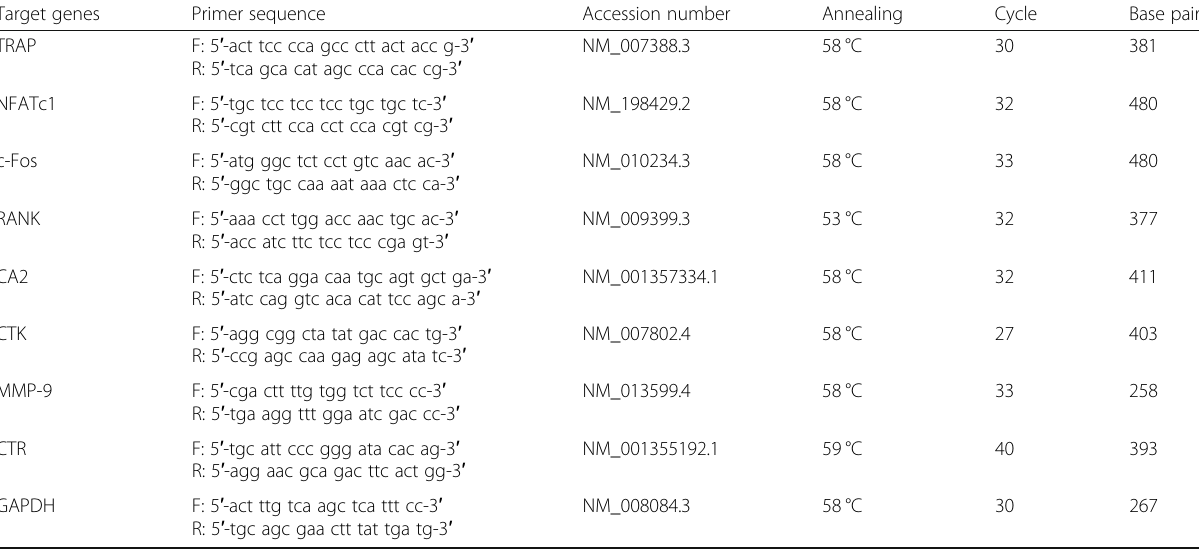
Table 1 Primer sequence for RT-PCR analysis Target